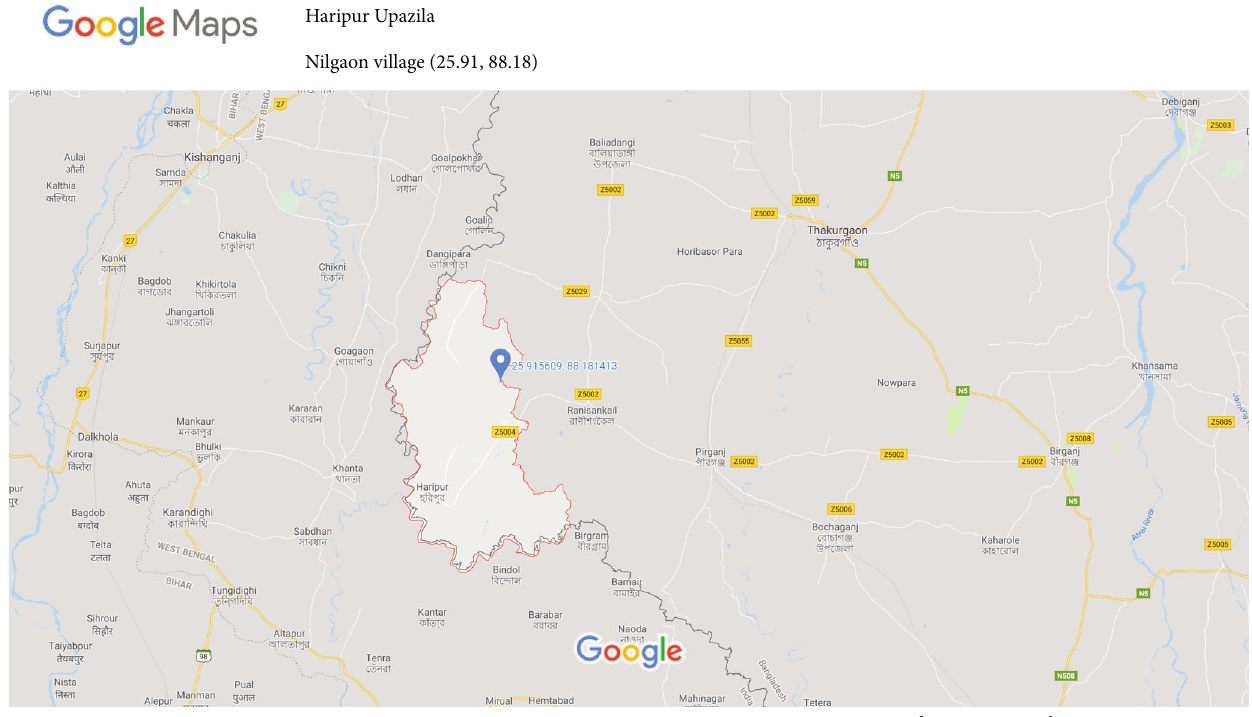
Figure 4: Geographical location of Nilgaon village in Haripur